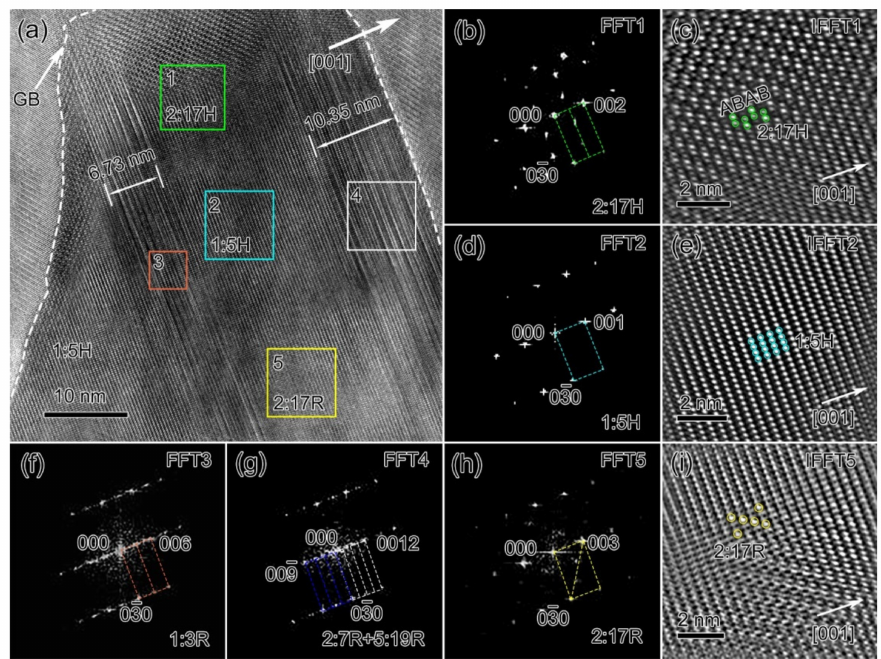
Figure 5. HR-TEM image ( a ), FFT patterns and IFFT images of the 2:17H phase ( b , c ), 1:5H precipi- tates ( d , e ), 1:3R precipitates ( f ), Sm n+1 Co 5n − 1 precipitates ( g ) and the 2:17R phase ( h , i ) at the grain boundary for solution-treated Sm 25 Co 46.9 Fe 19.5 Cu 5.6 Zr 3.0